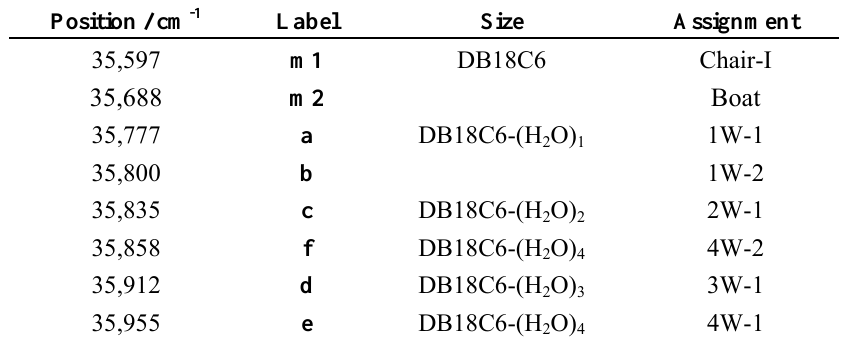
Table 1. Origin, positions, size and structural assignment for DB18C6 and its hydrated complexes. Position / cm -1